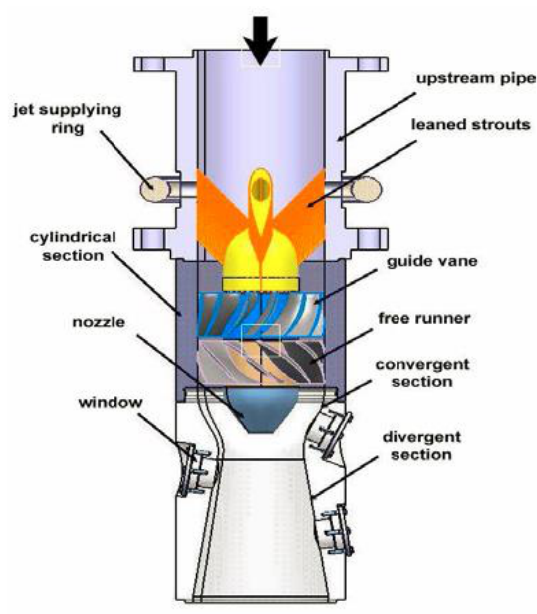
Fig. 4. Test apparatus at Politehnica Timisoara with free runner, plexiglass draft tube and set of pressure probes